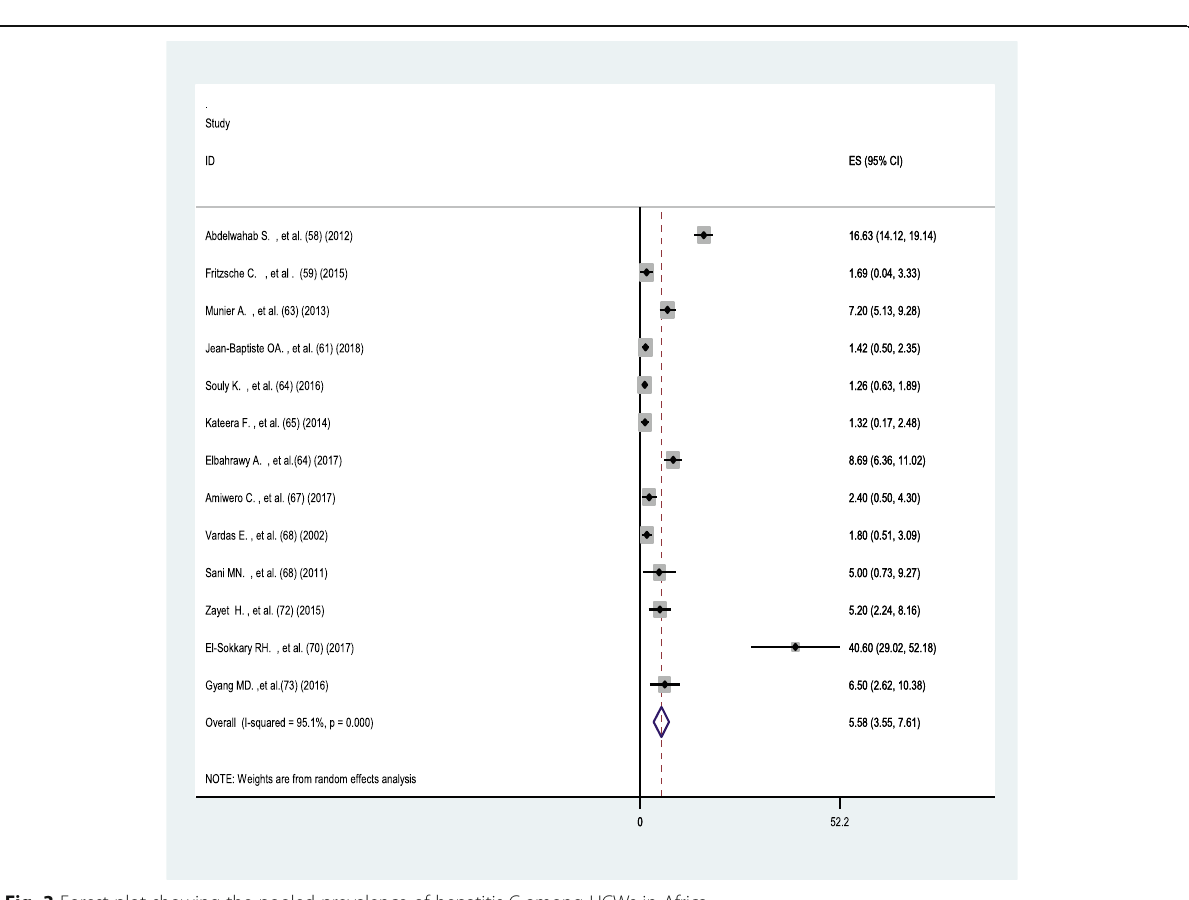
Fig. 3 Forest plot showing the pooled prevalence of hepatitis C among HCWs in